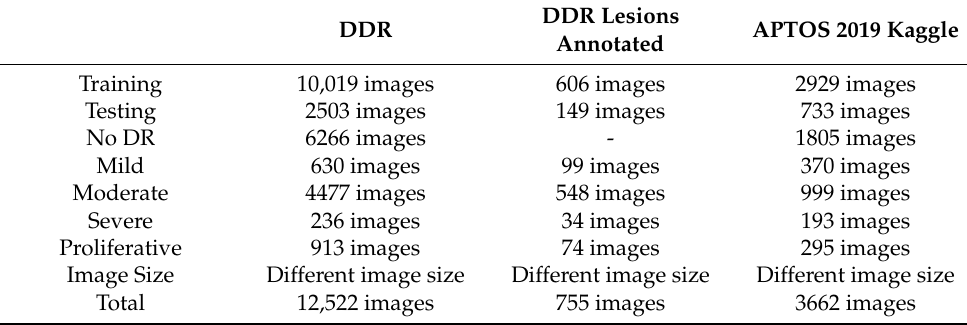
Table 3. The DR datasets details.